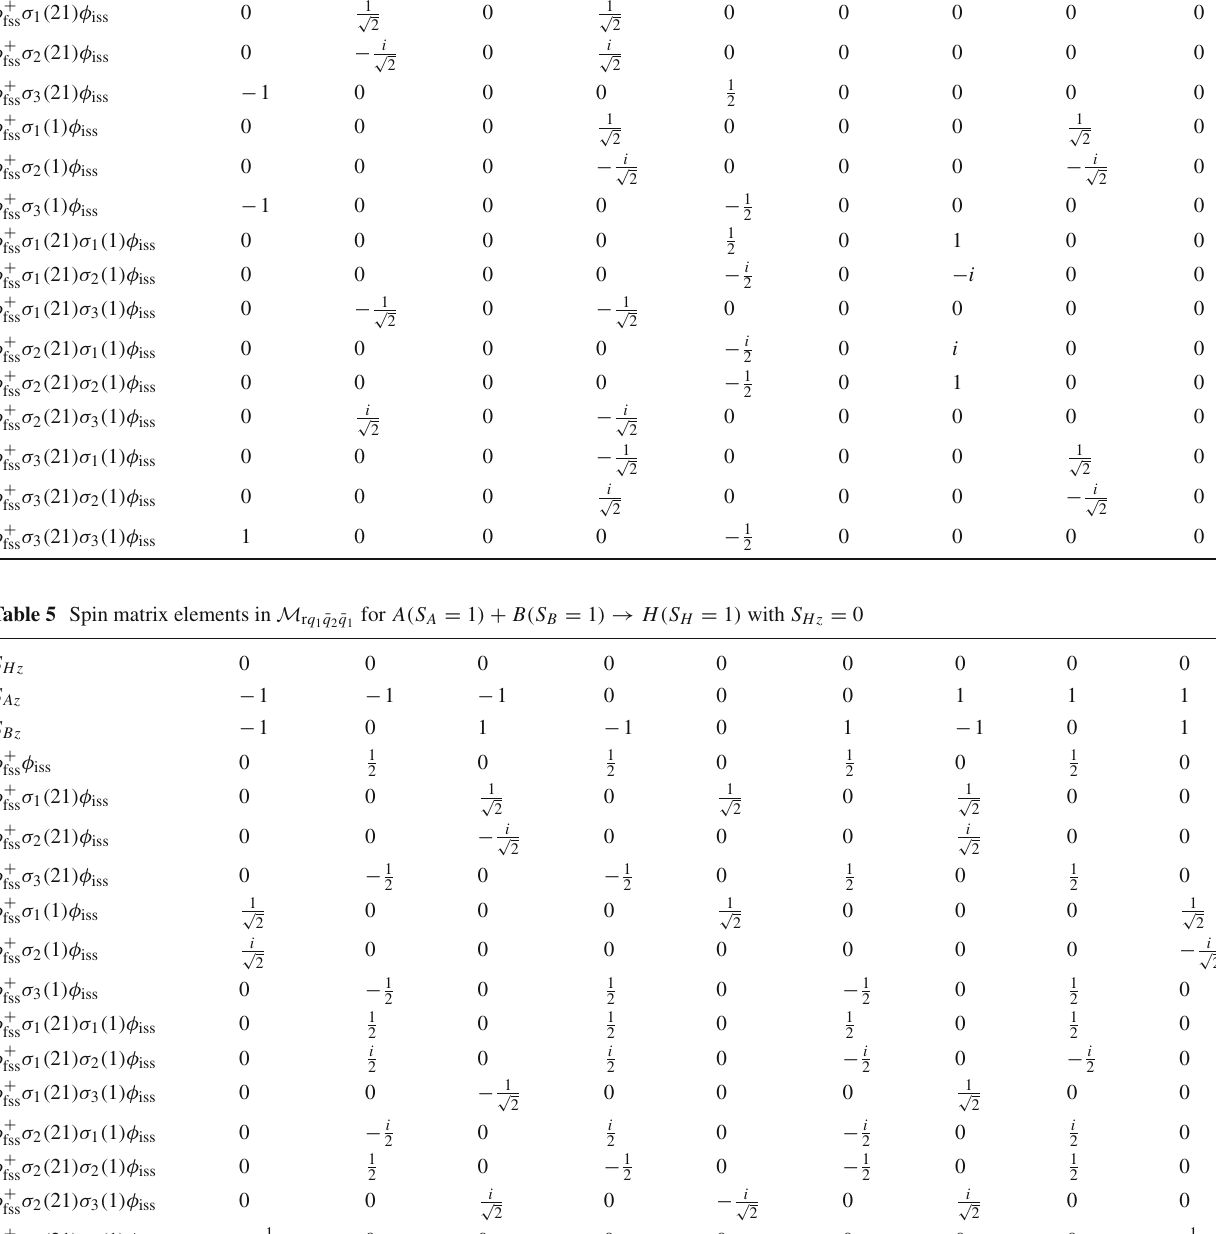
Table 4 Spin matrix elements in M r q